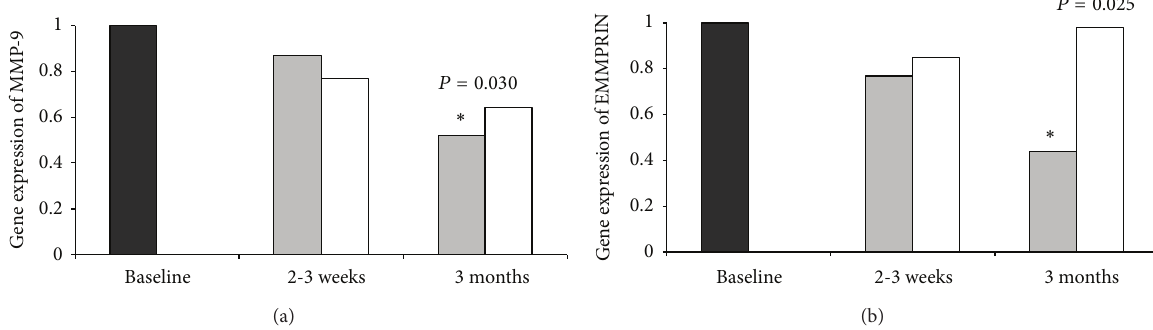
Figure 1: Gene expression of MMP-9 (a) and EMMPRIN (b) after 2-3 weeks and 3 months in the mBMC group and controls relative to baseline expression in the total population. Black bars: total group at baseline; grey bars: mBMC group; white bars: controls. ∗ indicates reduction from baseline to 3 months in the mBMC group 𝑃 values refer to differences in expression relative to baseline between